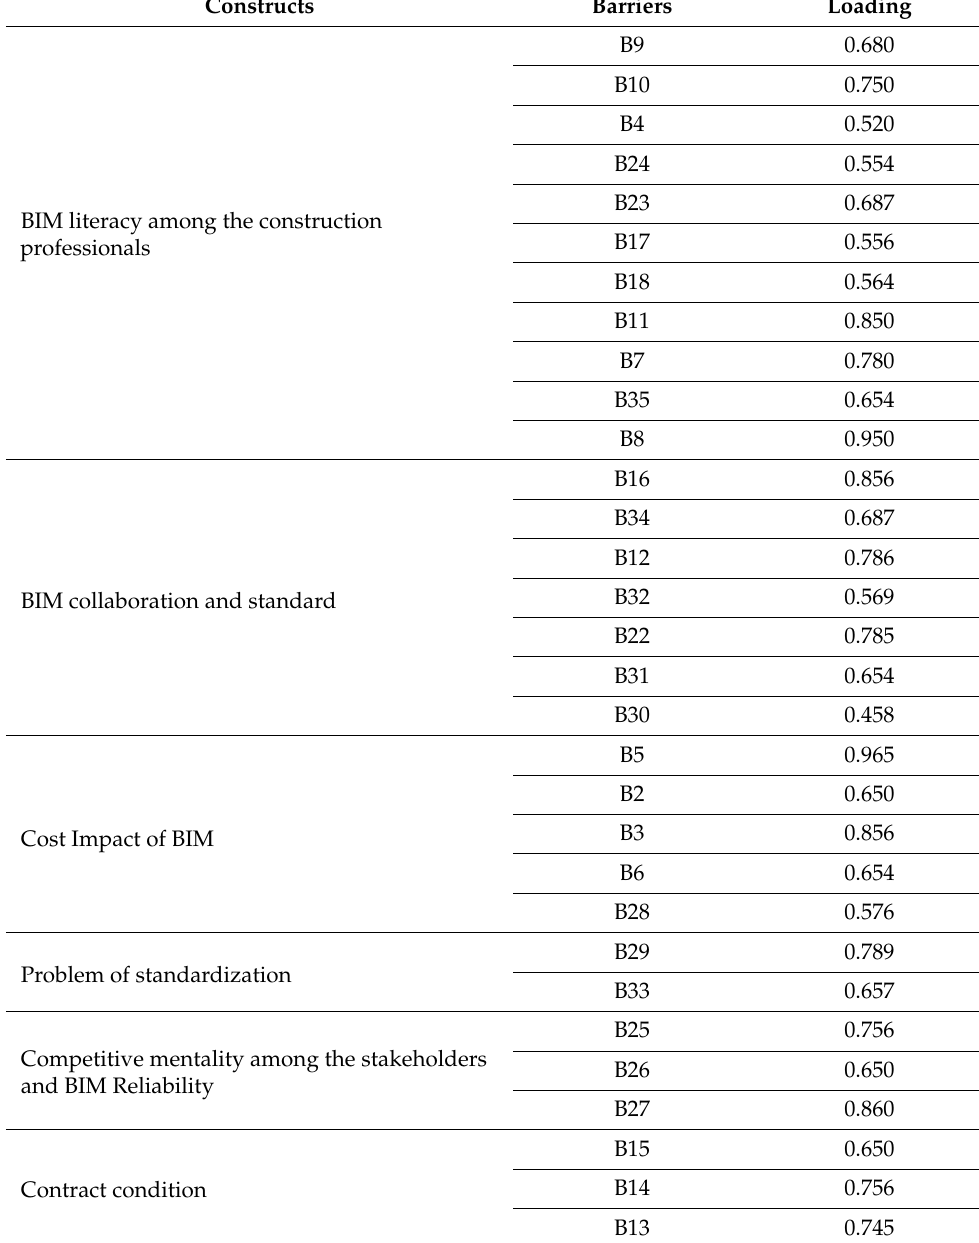
Table 5. Related components of the BIM